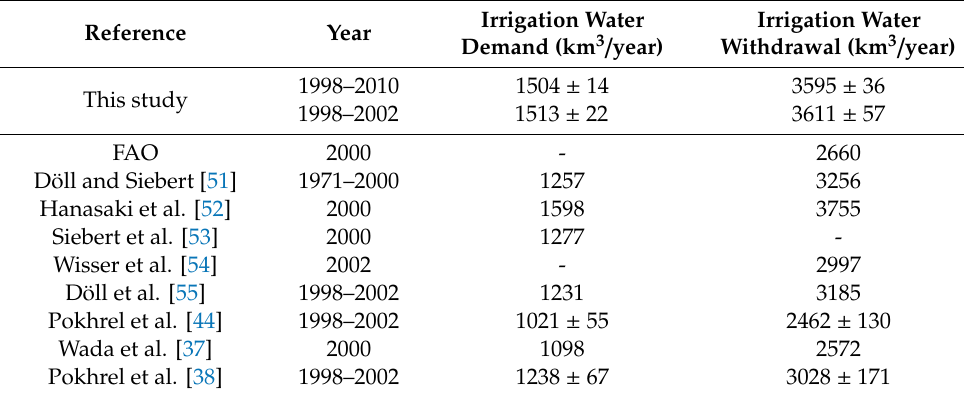
Table 2. Comparison of AGCM–Human simulated total irrigation water demand (actual use) and withdrawal (water withdrawn from source) with various previous estimates, including reported statistics and o ffl ine model results.